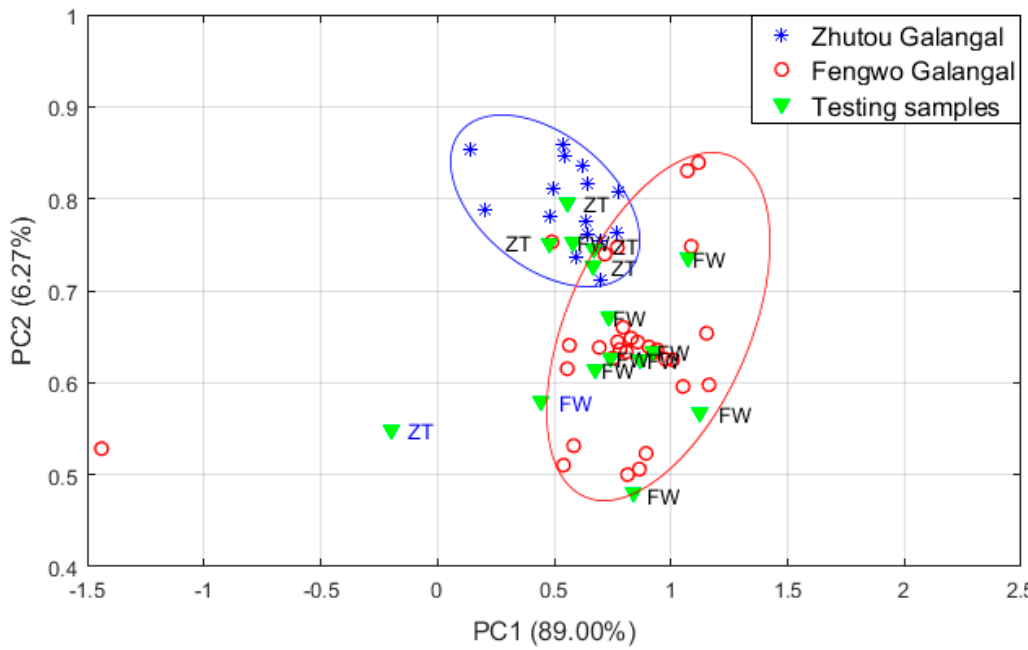
Figure 3. PCA classification results based on E-nose data of two cultivars A. officinarum . (ZT, FW are the labeling of the identification results of test samples, ZT, FW respectively represent Zhutou galangal and Fengwo galangal, and the result of blue font indicates misidentification.)